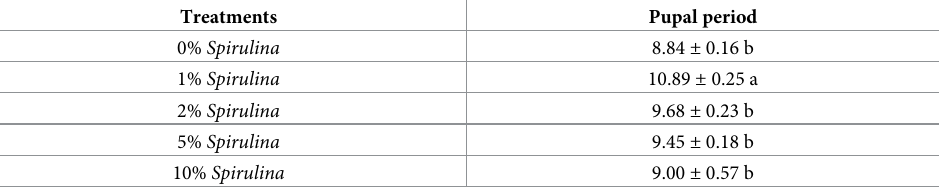
Table 3. Mean pupal period (days ± SE) of Cadra cautella pupae reared on Spirulina platensis added artificial diet under laboratory conditions at 25 ± 2˚C and 65 ± 5% relative humidity.